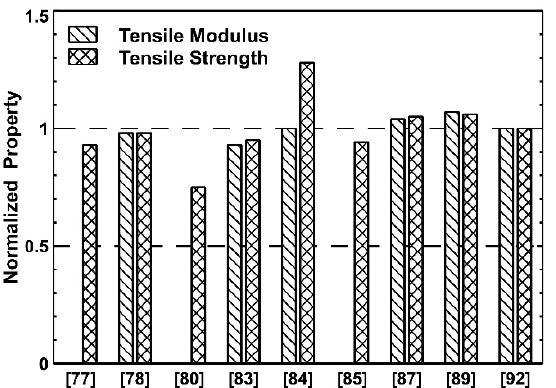
Figure 2. Values of tensile modulus and strength of the recycled CF, normalized against the virgin fiber values, for all references reporting such fiber values, for all references reporting such data.